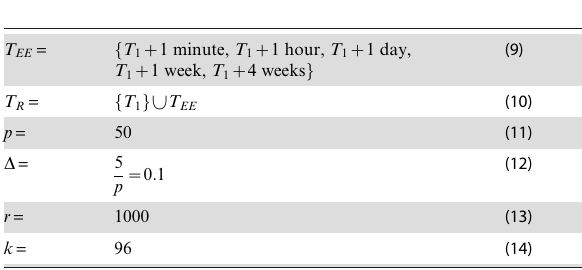
Table 3. Parameters for building the virtual